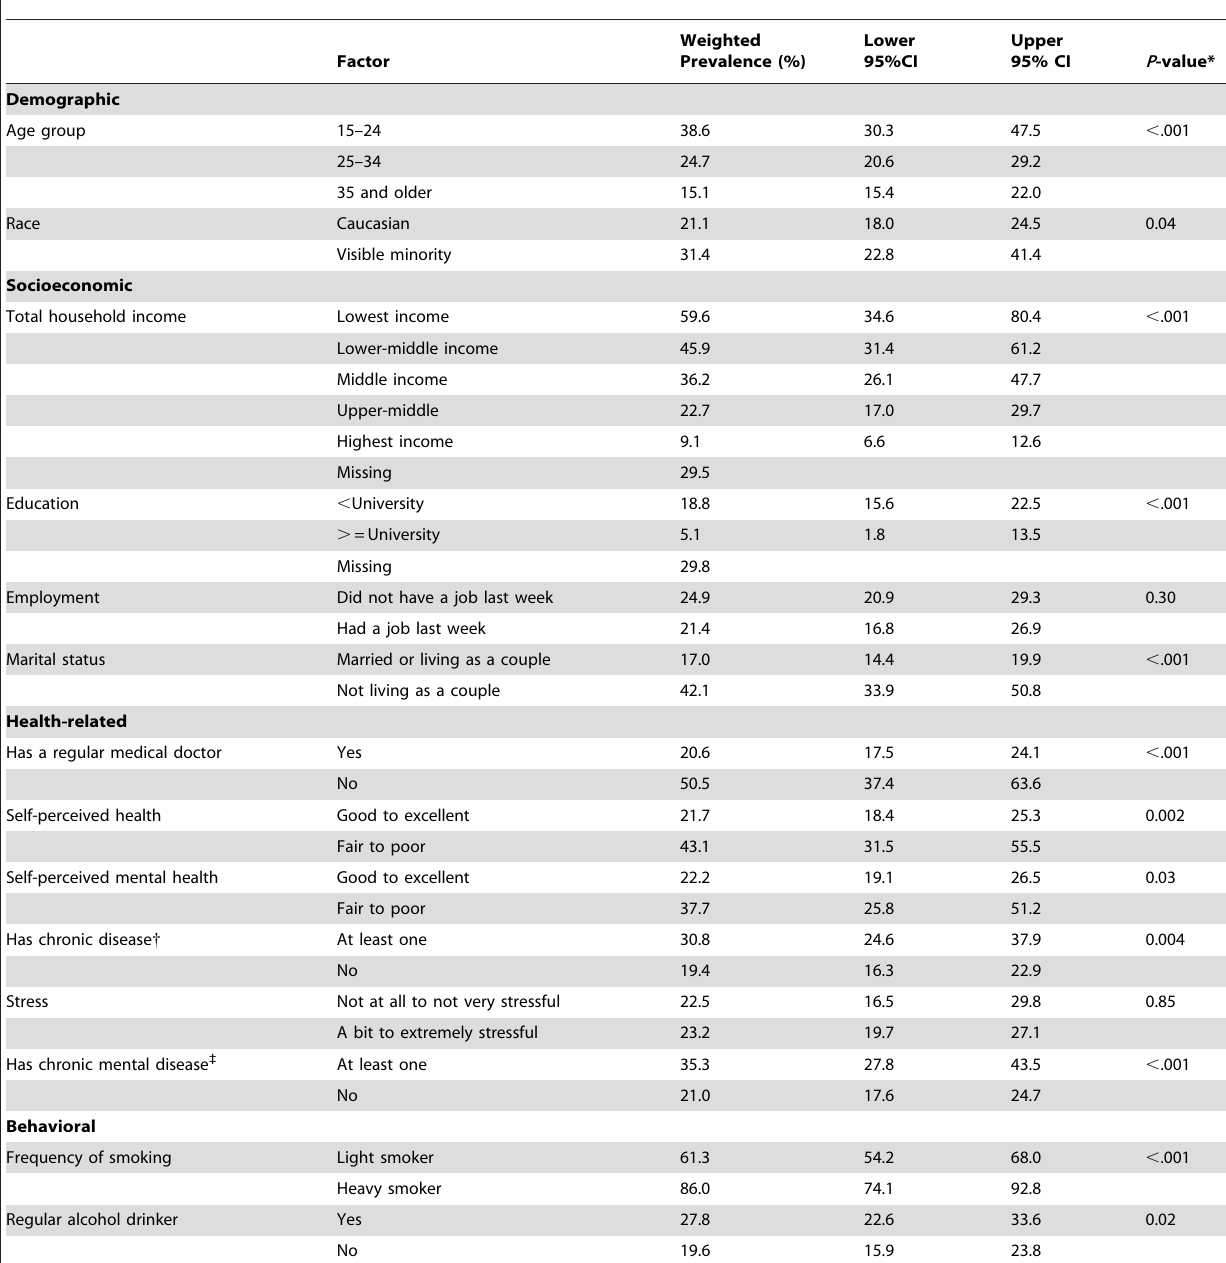
Table 2. Weighed prevalence (%) of smoking during pregnancy according to socioeconomic, demographic, behavioral, health- related